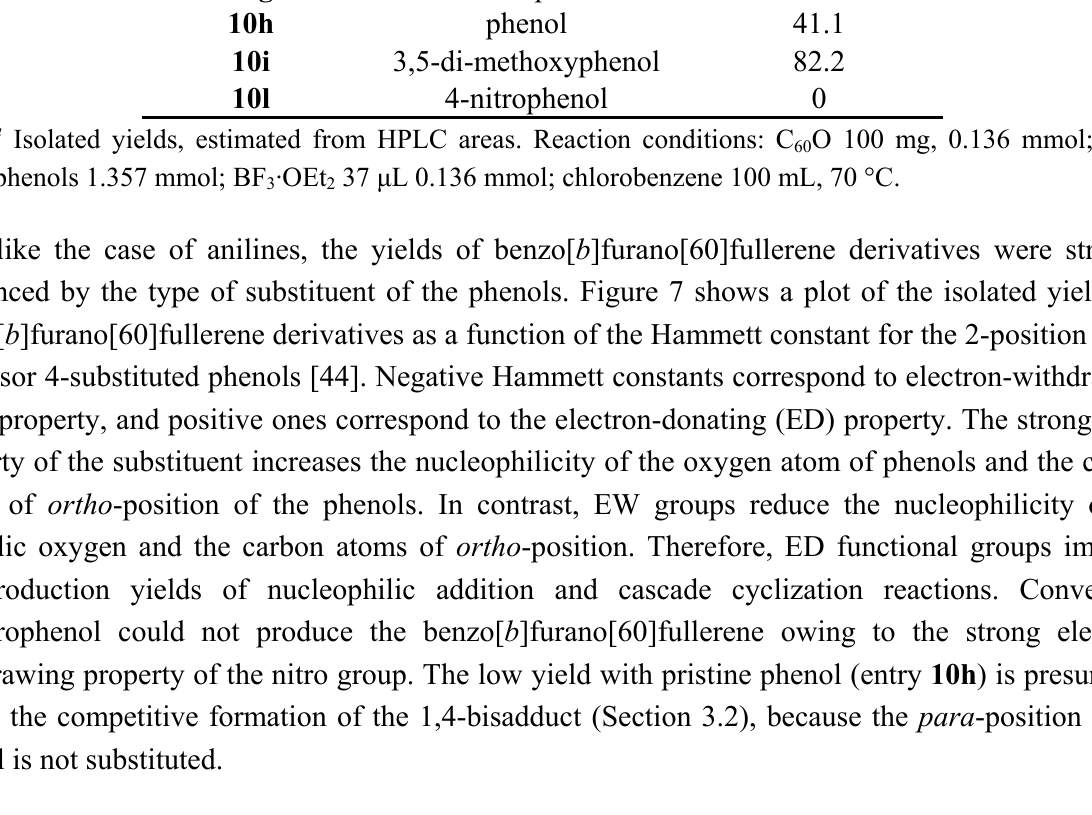
O 100 mg, 0.136 60